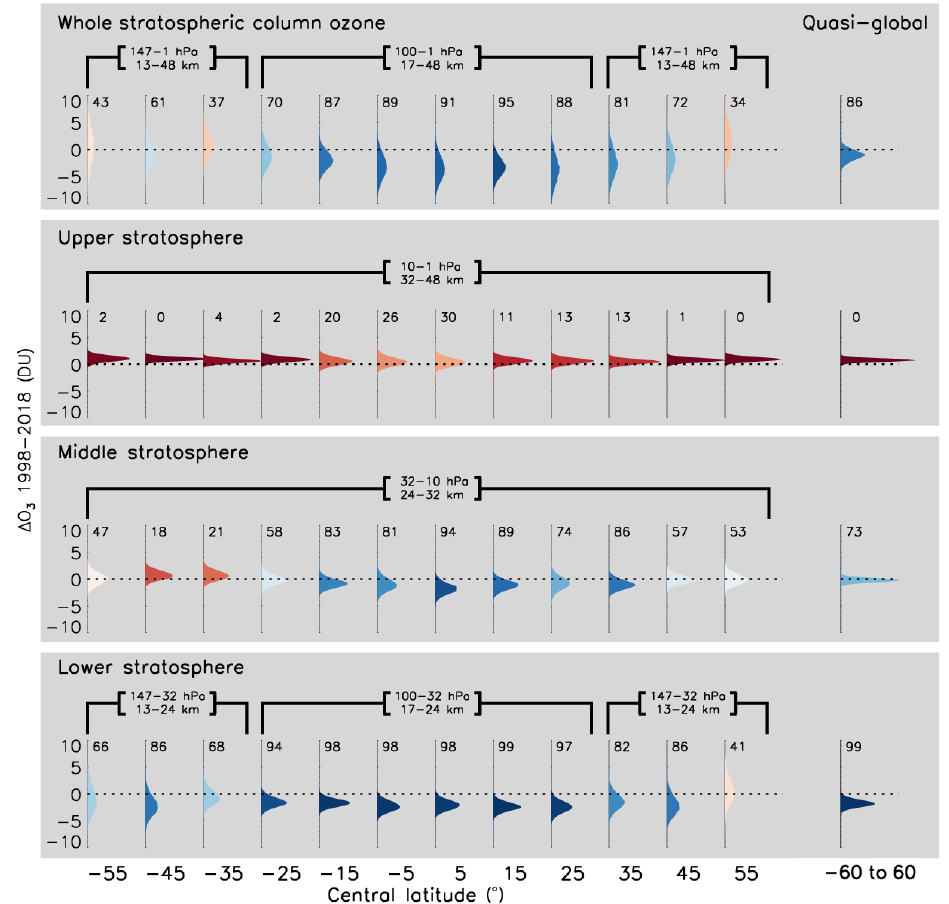
Figure 7. Posterior distributions (shaded) for the 1998–2018 partial column ozone changes. (Top) whole stratospheric column, (middle) upper, and (bottom) lower stratosphere in 10 ◦ bands for all latitudes (left) and integrated from 60 ◦ S–60 ◦ N (“Quasi-global”, right). The stratosphere extends deeper at midlatitudes than at equatorial latitudes (marked above each latitude). Numbers above each distribution represents the distribution percentage that is negative; colours are graded relative to the percentage distribution (positive, red hues, with values < 50; negative,